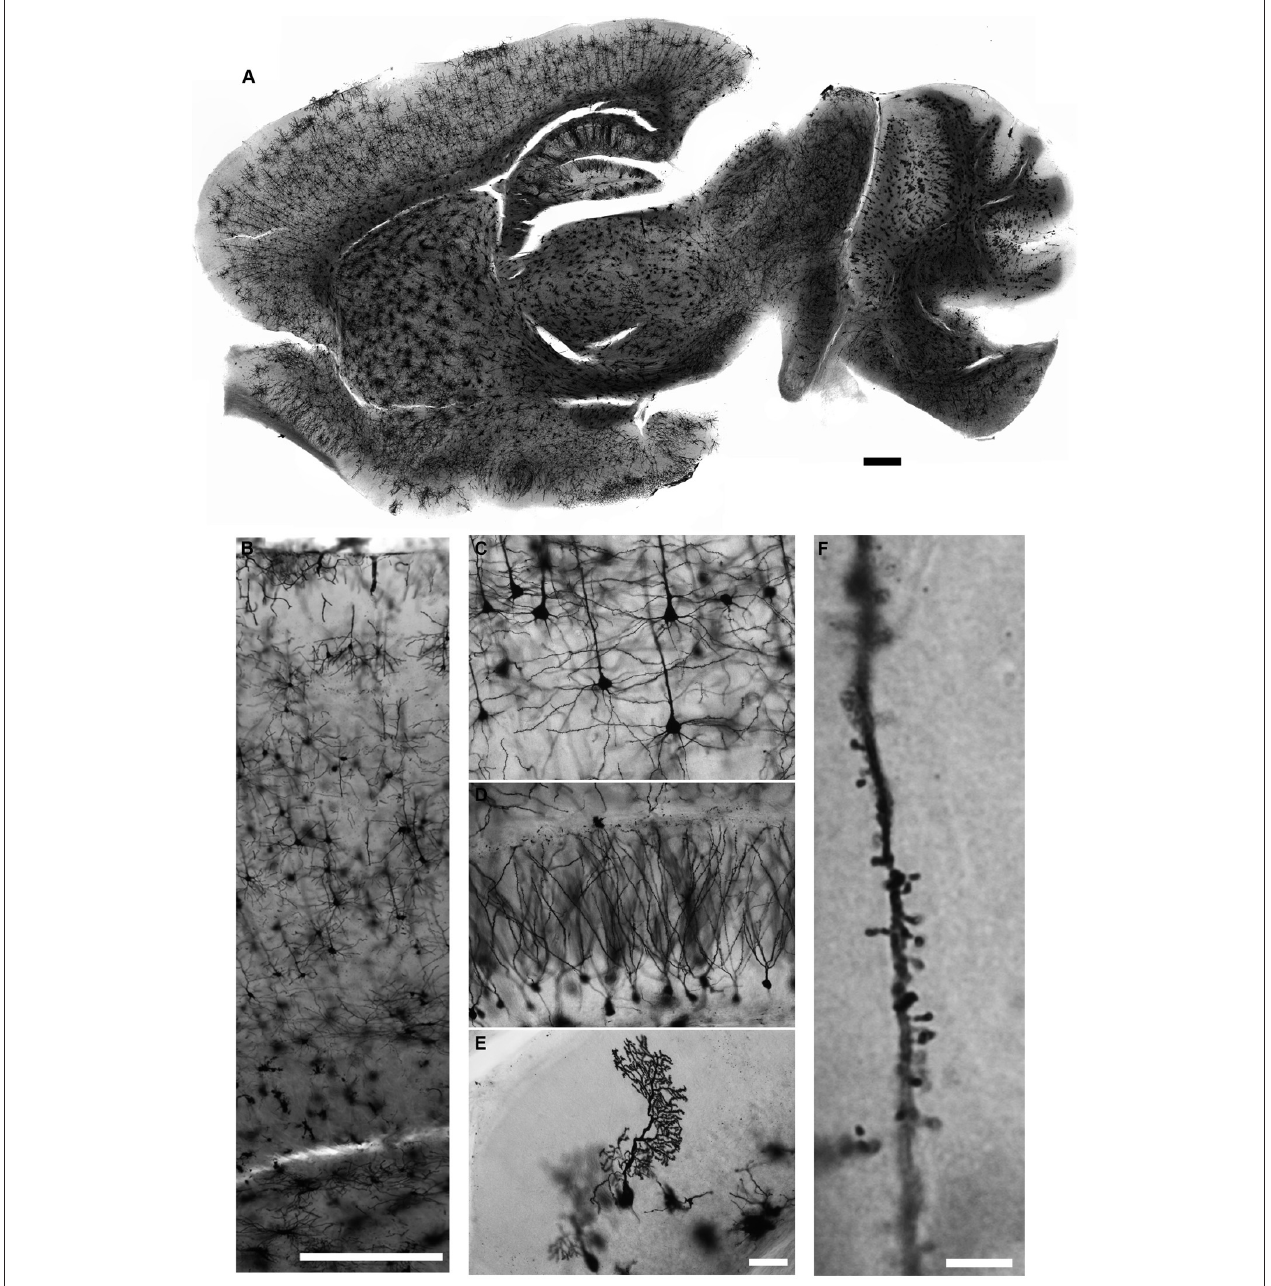
FIGURE 5 | Golgi-Cox staining for adult mouse brain . Neurons in all brain regions are evenly and reliably stained with the Golgi-Cox protocol described here (A) . Magnified images of cerebral cortex (B,C) , hippocampus (D) and cerebellar cortex (E) . Dendritic spines can also be visualized in much higher magnification (F) . (Golgi staining, DIC images, scale bars 500 µ m in (A,B) , 50 µ m in (E) and 5 µ m in (F)